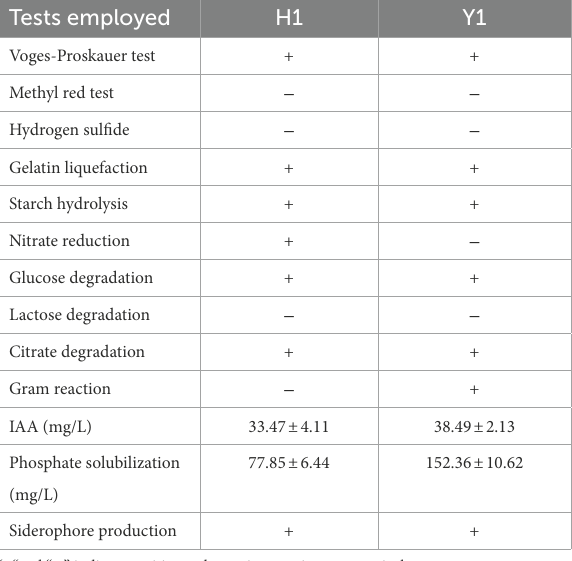
TABLE 2 Physiological and biochemical properties of Pseudomonas chlororaphis H1 and Bacillus altitudinis Y1. Tests